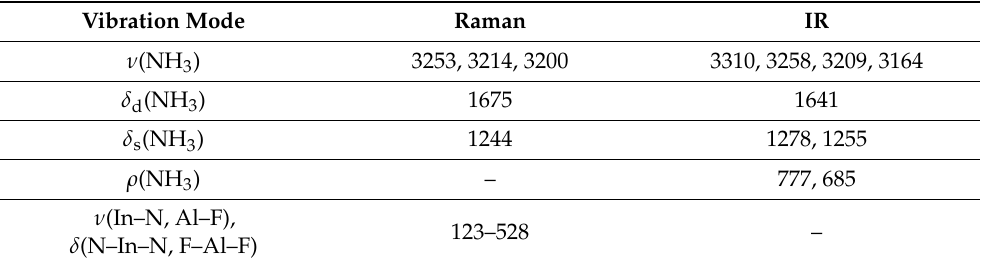
Figure 7. Top: IR spectrum of a powder sample of [In(NH 3 ) 6 ][AlF 6 ]; bottom: single crystal Raman spectrum of [In(NH 3 ) 6 ][AlF 6 ], excitation wavelength: 638 nm. Table 8. Observed vibrations in single crystal Raman spectroscopy and IR spectroscopy (in cm − 1 ) of [In(NH 3 ) 6 ][AlF 6